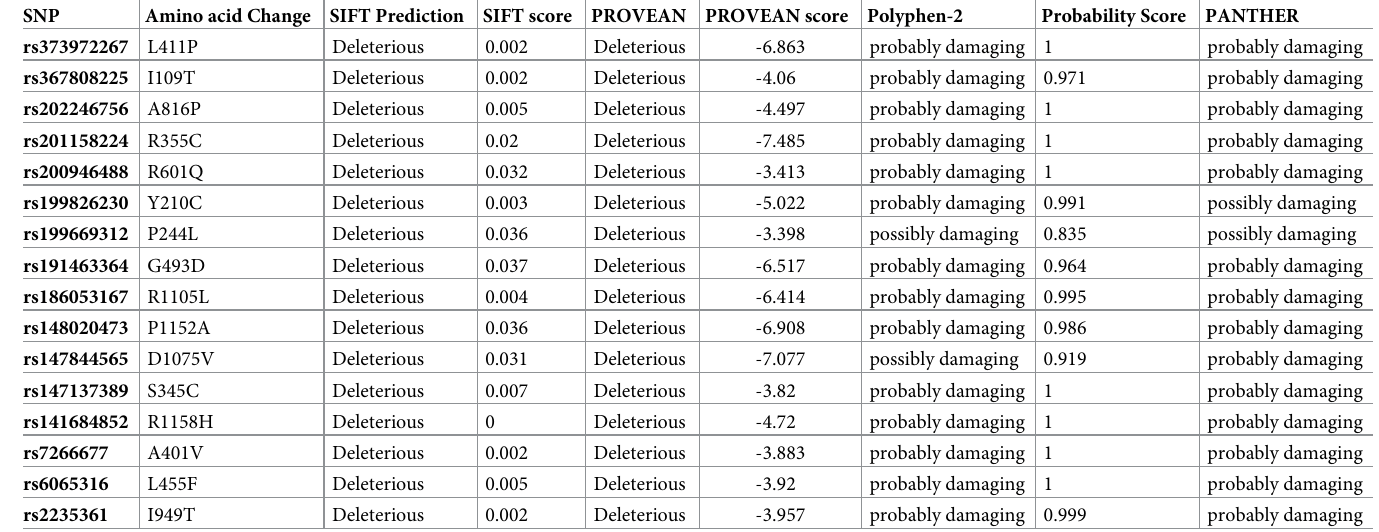
Table 1. Prediction of functionality of nsSNPs with SIFT, PROVEAN, Polyphen-2 & PANTHER. SNP Amino acid Change SIFT Prediction SIFT score PROVEAN PROVEAN score Polyphen-2